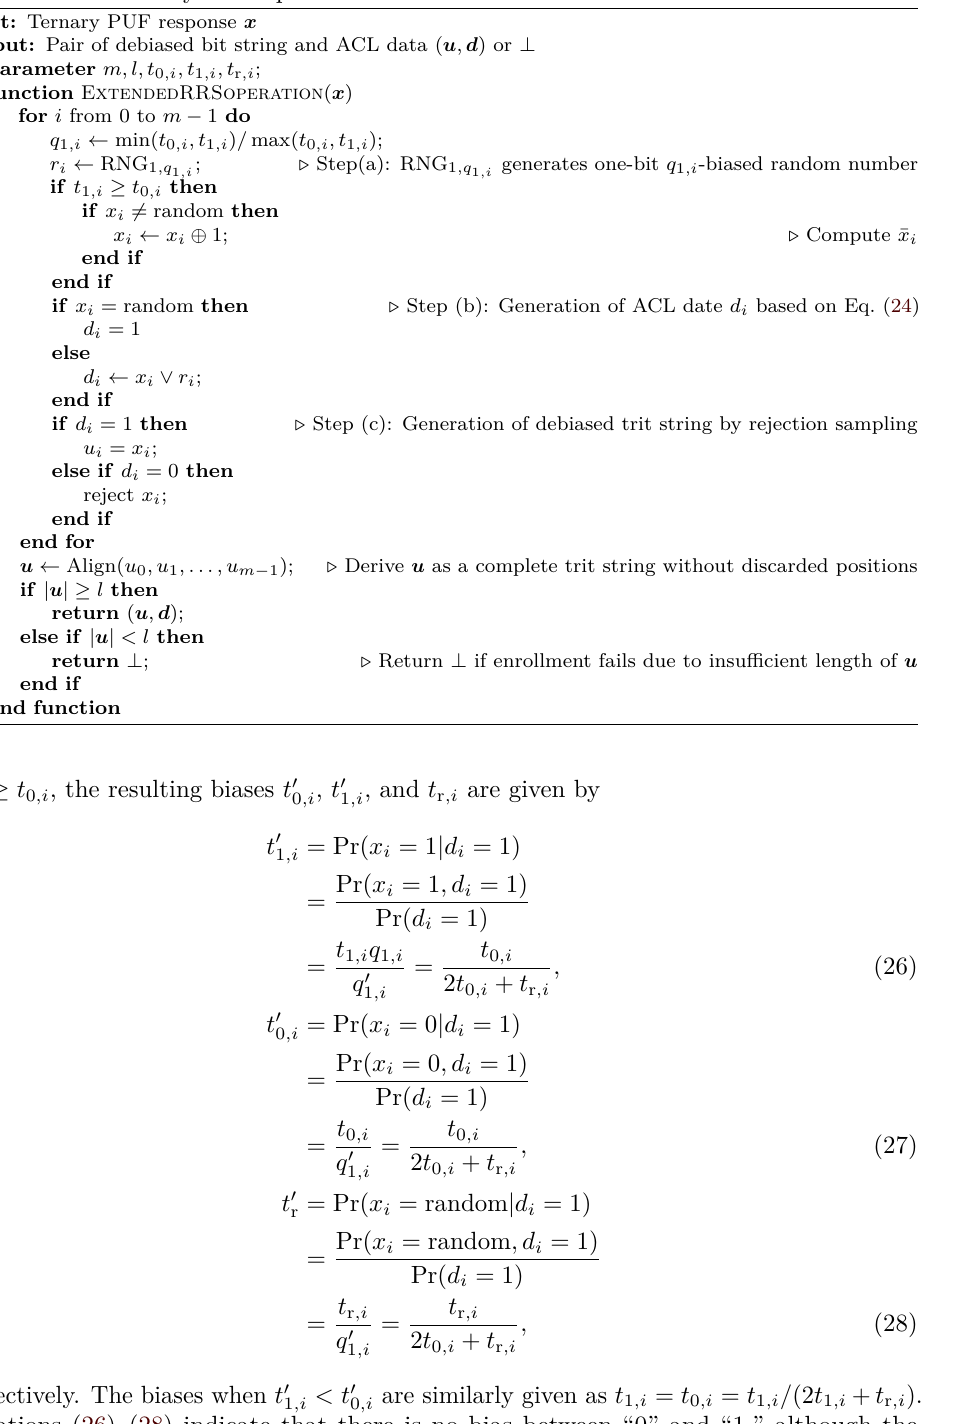
Algorithm 4 Ternary RRS operation based on cell-wise bias